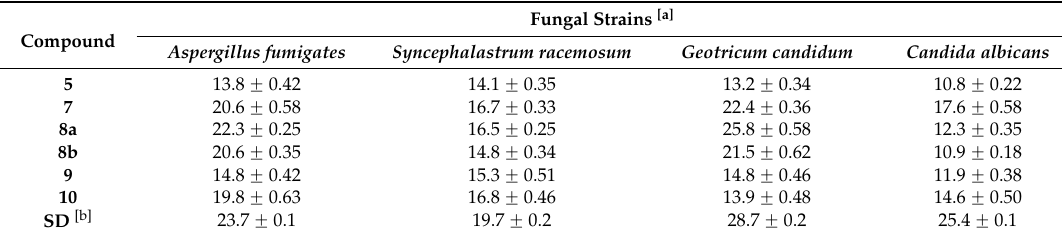
Table 2. Antifungal activity of the synthesized thiophene derivatives 5 , 7 , 8a – b , 9 and 10 .